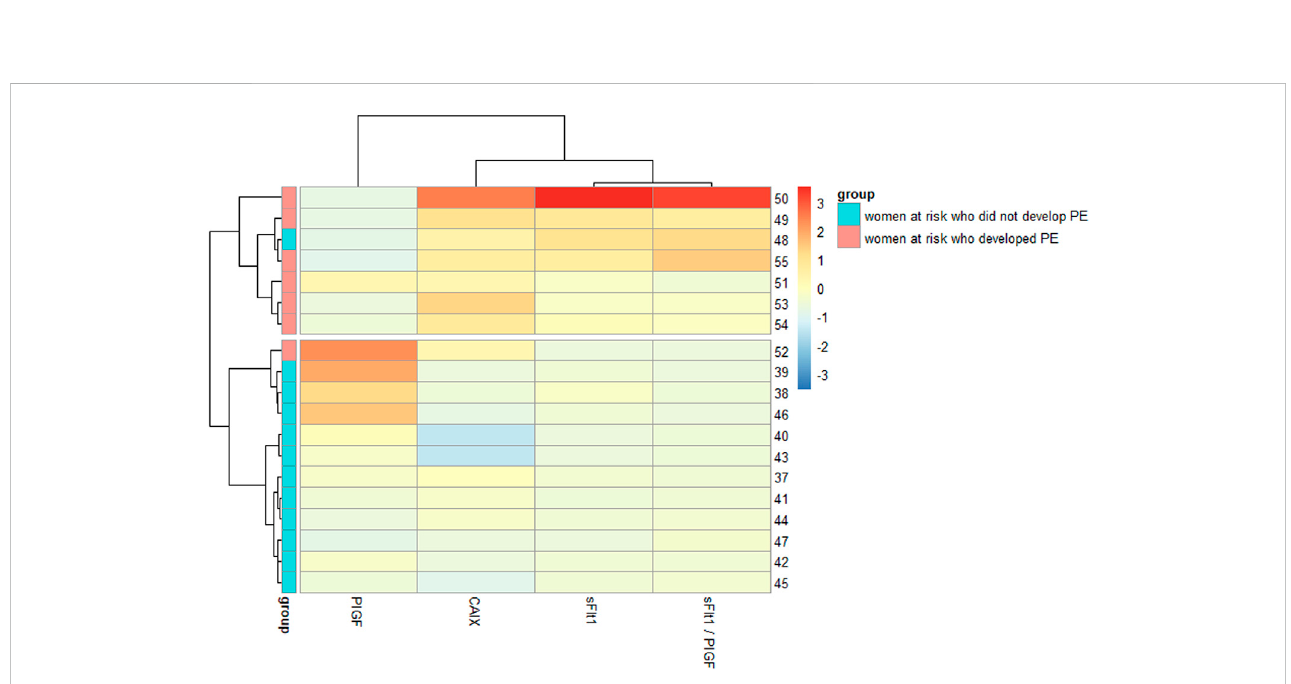
FIGURE 6 Heatmap of CAIX, sFlt1, and PlGF in women who later developed the pathology and in women who did not at 28 – 32 gestational